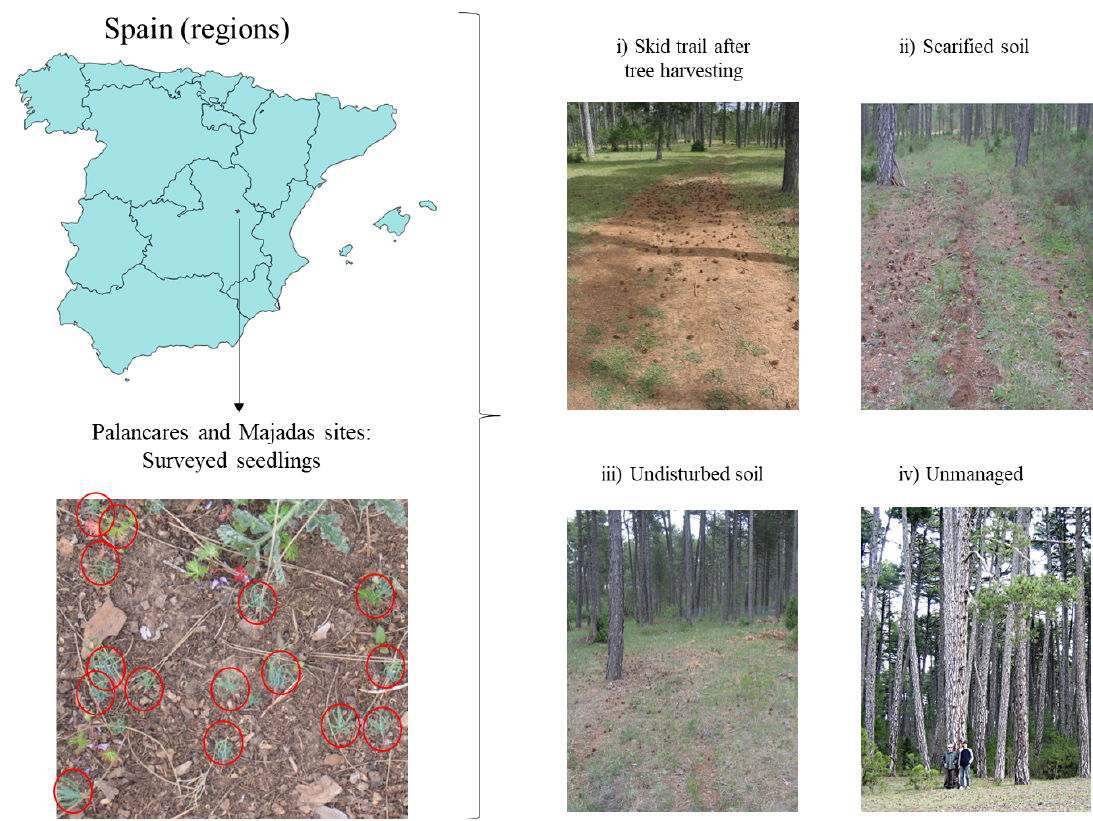
Figure 1. Study site and experimental conditions of Spanish black pine forests subjected to treatments in Cuenca Mountains (Spain).